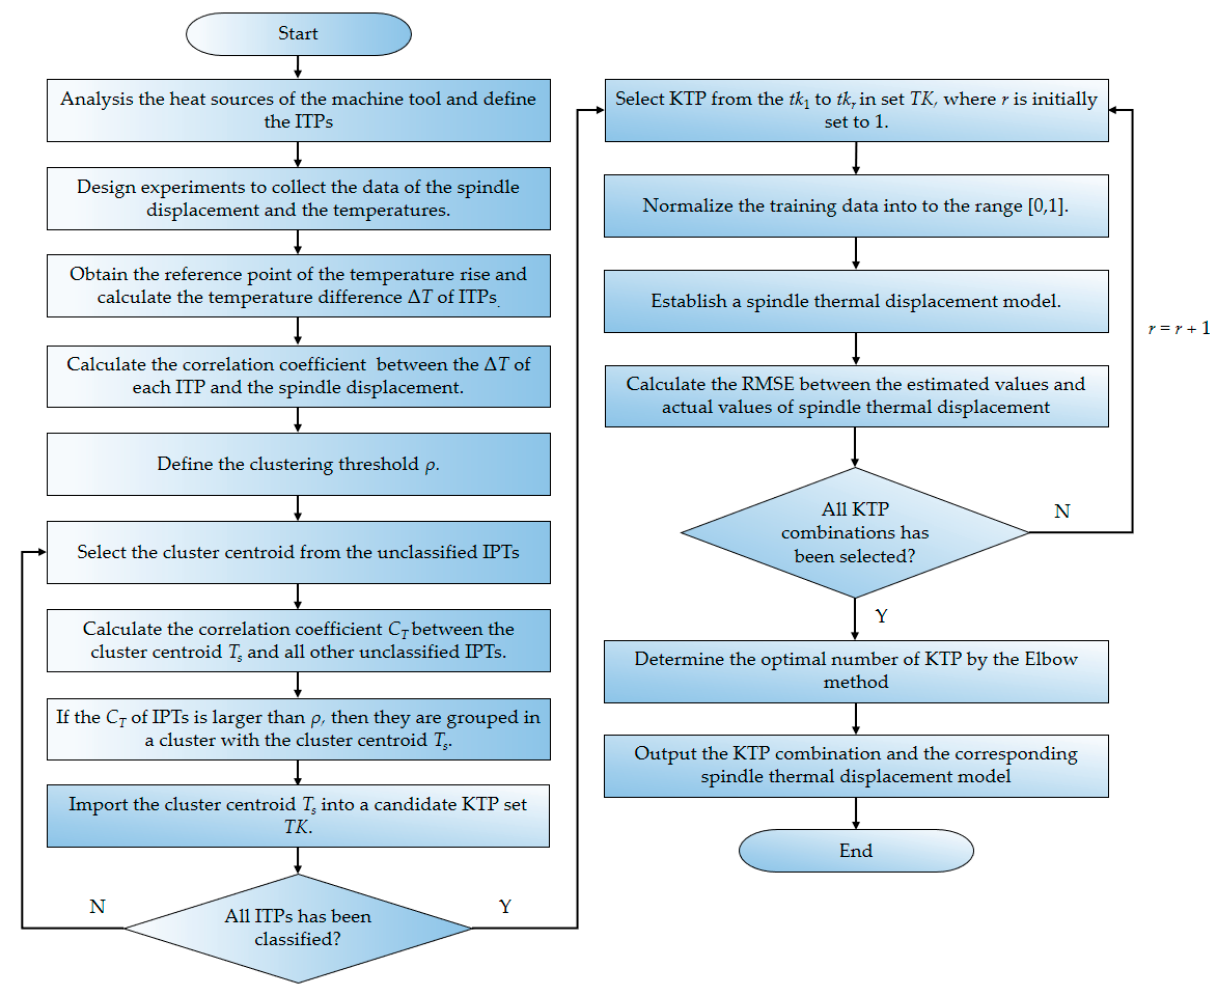
Figure 1. The flowchart of the proposed method.